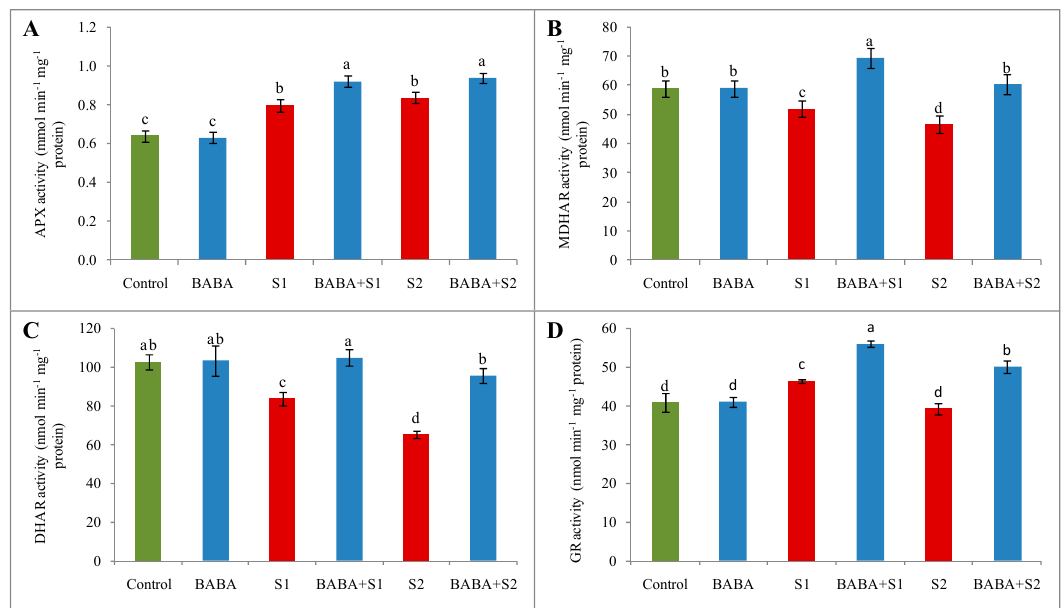
Figure 4. Effect of BABA on activity of APX ( A ), MDHAR ( B ), DHAR ( C ), and GR ( D ) of rapeseed ( Brassica napus L.) seedlings exposed to different concentrations of salt stress. Means ( ± SD) were calculated from three replications (n = 3) for each treatment. Average of three replications (n = 3) was used to determine mean ( ± SD) for each treatment. Letters with different values varied significantly at p ≤ 0.05 according to Fisher’s LSD test. Here, BABA, S1 and S2 indicate 150 µ M β -aminobutyric acid, 100 mM NaCl and 150 mM NaCl, respectively.